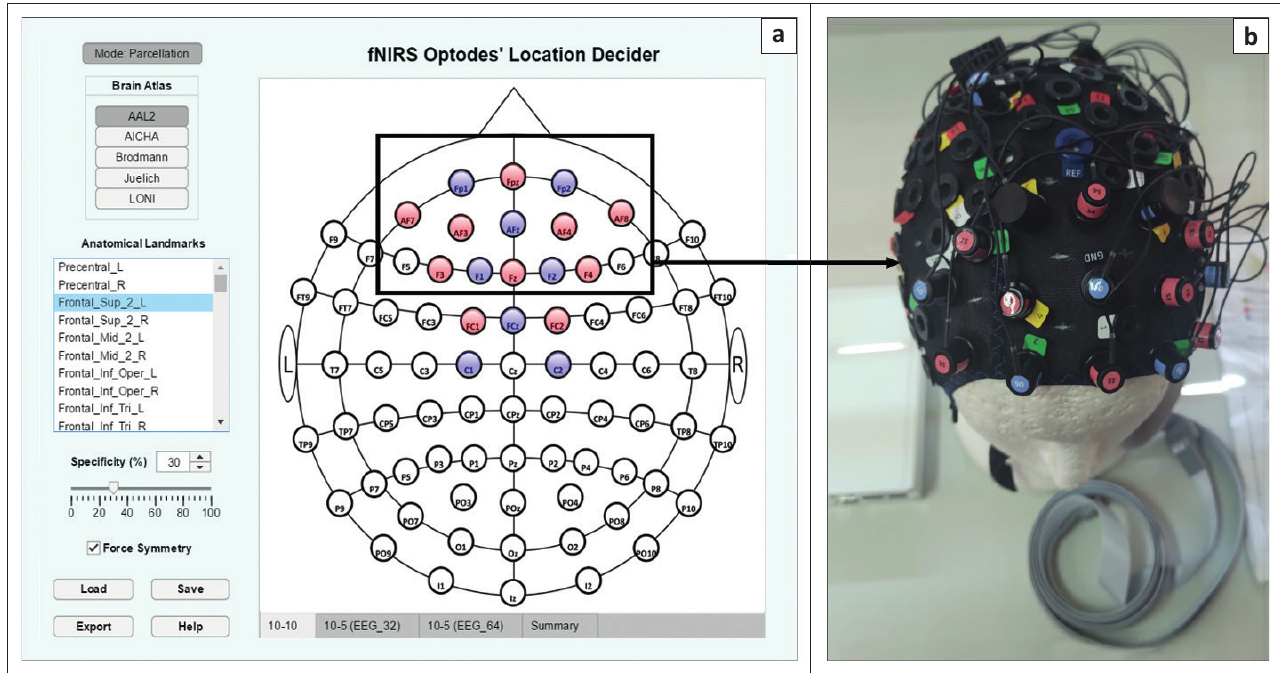
FIGURE 5: Region of interests and optodes montage. (a) Example of the fNIRS optodes’ location decider interface (Zimeo Morais et al. 2018). Five options of Brain Atlas are shown on upper left panel. In this example, the automated anatomical labelling atlas (AAL2) was chosen. A list of anatomical landmarks is depicted in the left middle panel. For illustration purposes, we chose the superior frontal cortices bilaterally. The left bottom panel is the specificity, which is the minimum landmark portion relative to the brain that a channel needs to cover to be included in the montage layout. The bottom box shows force symmetry that forces optodes’ symmetry between left and right hemispheres. The right panel is the EEG-10-10 system layout (by dividing the distance in EEG 10-20, we can make 10-10 system). Red and blue circles represent source and detectors, respectively. (b) A real fNIRS cap with the respective montage represented by the delimited black rectangle in